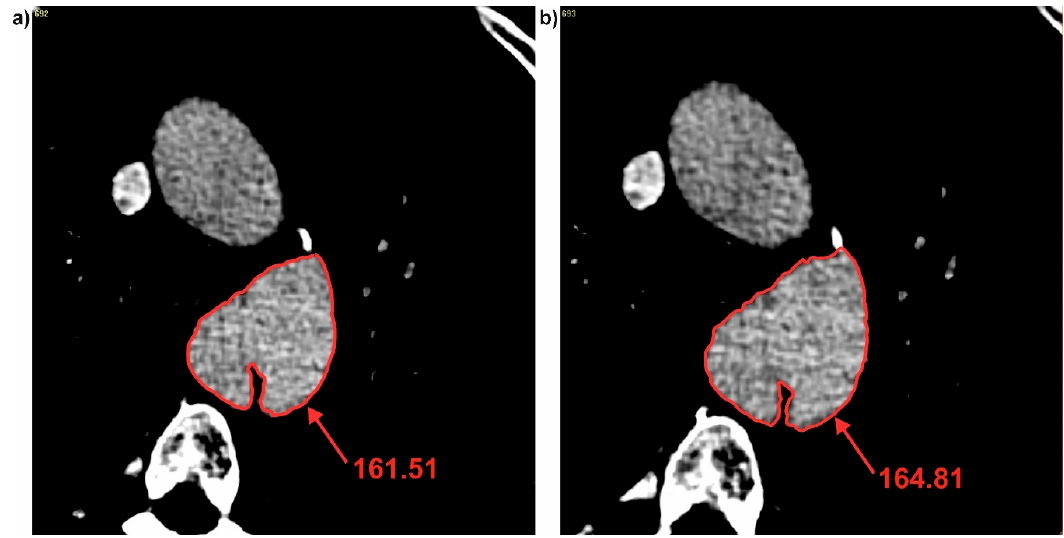
Figure 6. Brightness of common duct for P1: ( a ) Cross-section number 3 and ( b ) cross-section number 4. Values of brightness were calculated in Pixels.